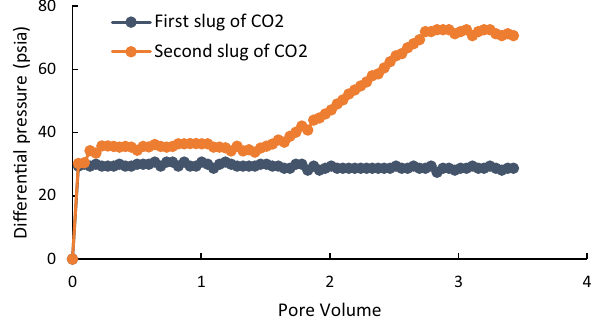
Fig. 7 Performance of injected CO 2 slug before and after blended surfactant solution of 0.4%SDS + 0.4%AAS